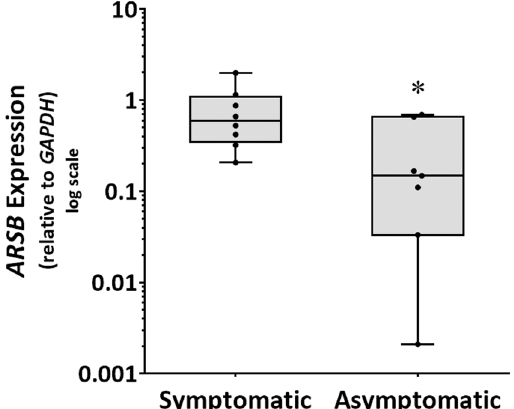
Figure 2. Expression of the ARSB gene within carotid atherosclerosis of patients with and without symptoms of cerebral embolization. Increased expression of ARSB within carotid atheroma biopsies of symptomatic (N = 8) compared to asymptomatic (N = 7) patients ( * P = 0.029). Data expressed as median and interquartile range with maximum and minimum data points (whiskers) for relative expression and compared by Mann-Whitney U